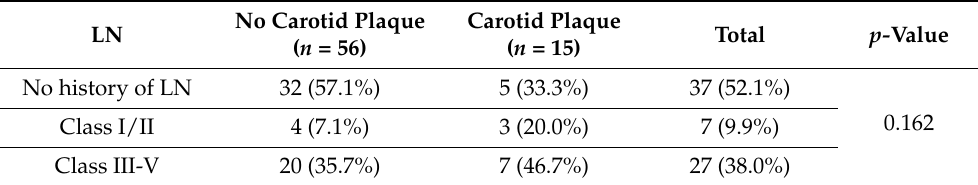
Table 3. Lupus nephritis.